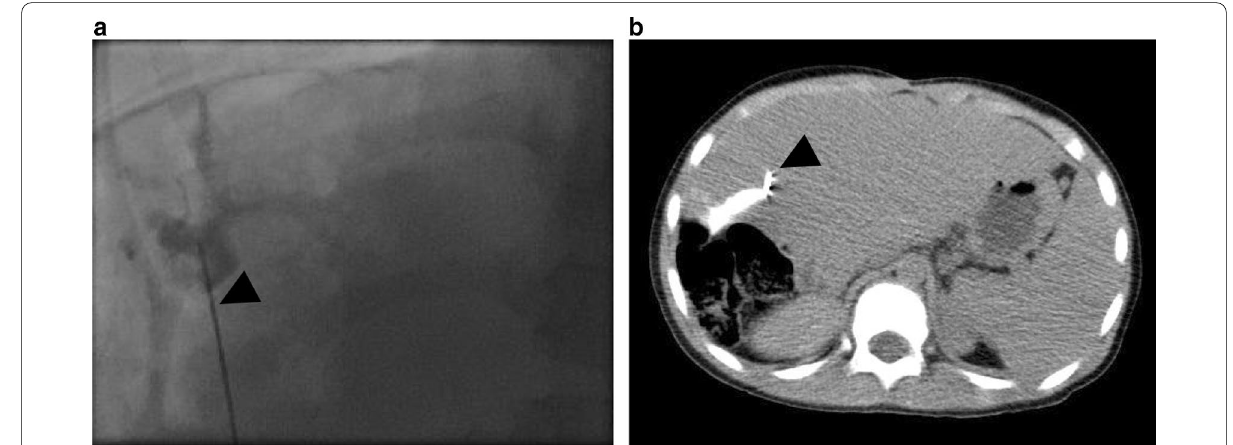
Fig. 4 Percutaneous transhepatic puncture and sclerotherapy of the varices was performed. a Intraoperative radiograph. b Intraoperative computed tomography image. The black arrowhead indicates the needle